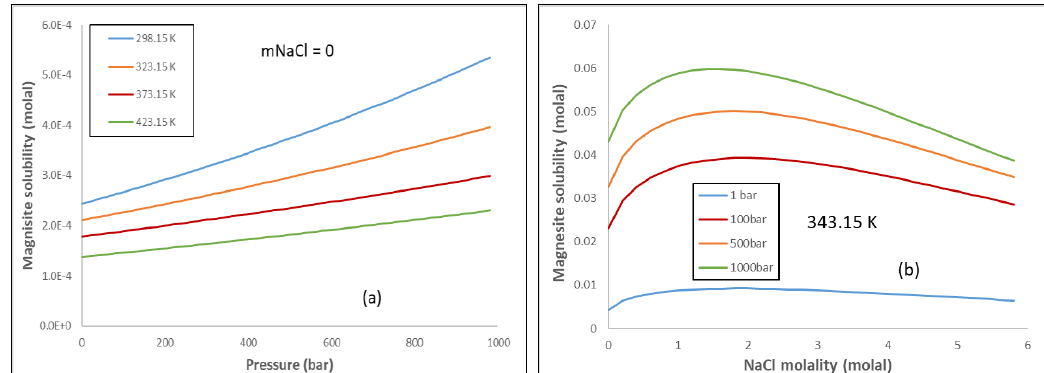
Figure 8. Magnesite solubility in pure water or NaCl solutions calculated by this work at various values of pressure, temperature and NaCl molality of the solution. ( a ) Magnesite solubility in pure water varying with pressure at different temperature. ( b ) Magnesite solubility in NaCl solutions varying with NaCl molality at 343.15 (K) and various pressures.